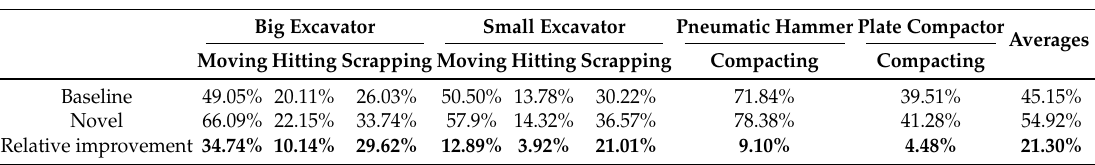
Table 6. Machine + activity identification mode rate comparison between the baseline and